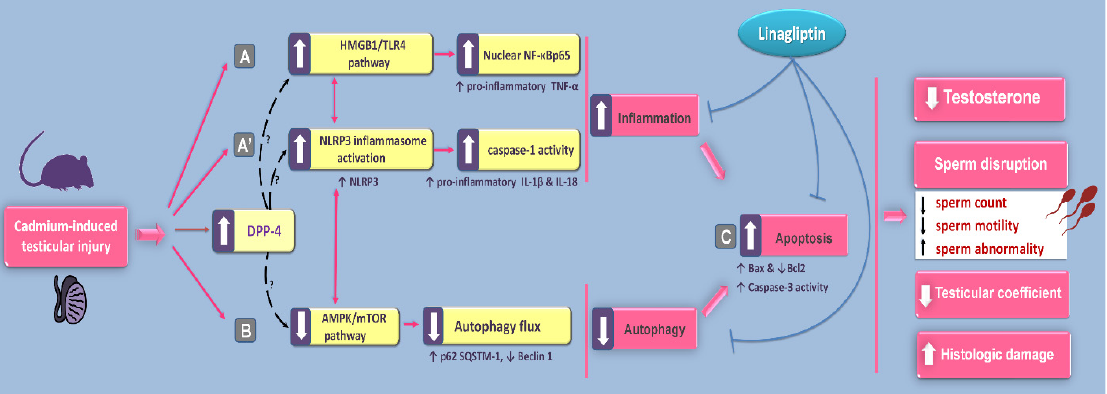
Figure 11. An outline of the mechanisms that intercede linagliptin’s amelioration of cadmium-evoked testicular impairment. According to the current findings, the proposed mechanisms are: ( A , A’ ) Curbing the inflammatory responses, including HMGB1/TLR4/NF- κ B and NLRP3/caspase-1/IL-1 β pathways in the testes of cadmium-intoxicated rats. ( B ) Stimulation of the autophagy response with activation of AMPK/mTOR pathway in the testes of cadmium-intoxicated rats. ( C ) Interference with the pro-apoptotic responses, including Bax downregulation, Bcl2 upregulation, and caspase 3 inhibition in the testes of cadmium-intoxicated rats. Of note, the beneficial outcomes of linagliptin are mainly due to DPP-4 inhibition, which has been linked to marked anti-inflammatory/immune- modulatory actions [21,22]. DPP-4 inhibition triggers several downstream targets, including the upregulated protein expression of SDF-1 α , which prompts intensified testicular repair and regen- eration [21,33]. Moreover, the beheld activation of autophagy may suppress the pro-inflammatory responses/NLRP3 inflammasome activation [12,20] and limit the proapoptotic responses [12,17,19] in the testes of cadmium-intoxicated rats. Activation is represented by solid arrows, whereas inhibition is depicted by blunt arrows. The question marks denote unknown